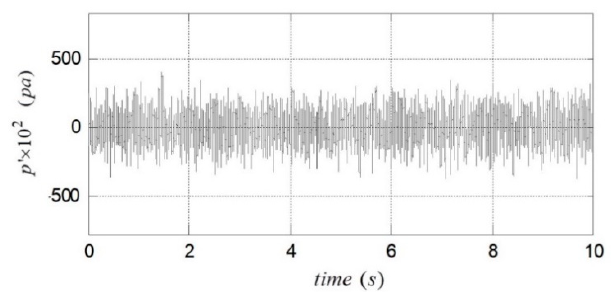
Figure 12. Time history of acoustic pressure measured by validation hydrophone.